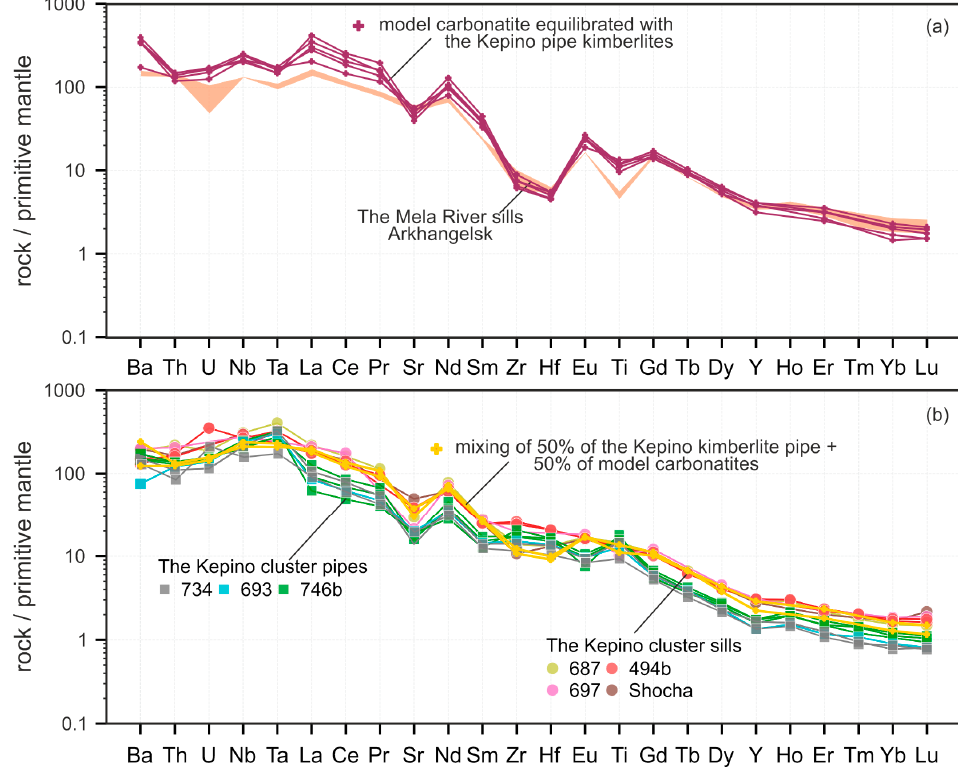
Figure 14. Trace element abundances for the Mela River kimberlite-carbonatite in comparison with modeled immiscible carbonatite melts equilibrium with kimberlite of the Kepino pipes ( a ), and the model mixture of 50% kimberlite of the Kepino pipes and 50% modeled carbonatite melt in comparison with kimberlite of the Kepino sills ( b ). Modeled carbonatite melts are computed as immiscible with kimberlite based on KDs for hydrous CO 2 -bearing potassic system at 1.7 GPa and 1220 °C [74].